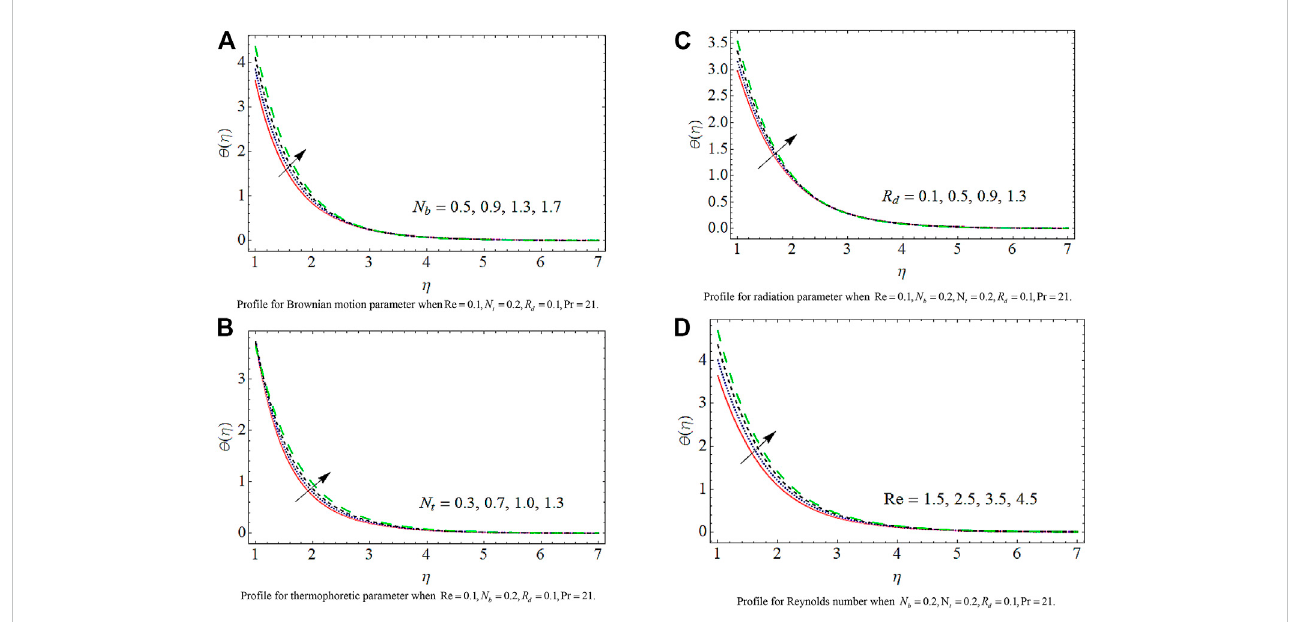
FIGURE 3 Temperature pro fi les under the impact of various substantial